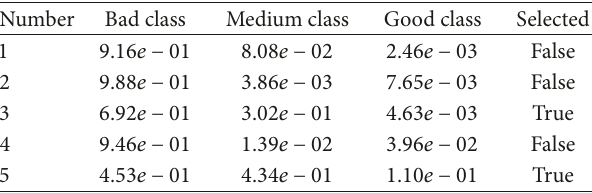
Table 5: Select samples for bud